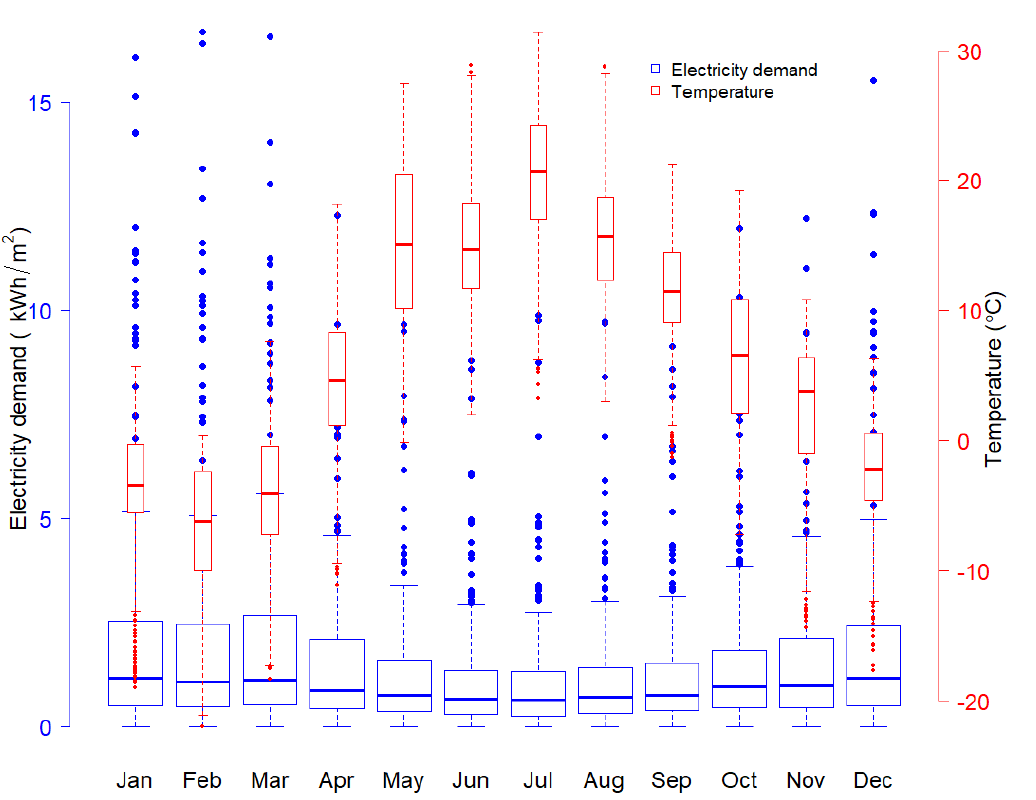
Table 2. Electricity demand per month: averages, minimum, maximum and median.